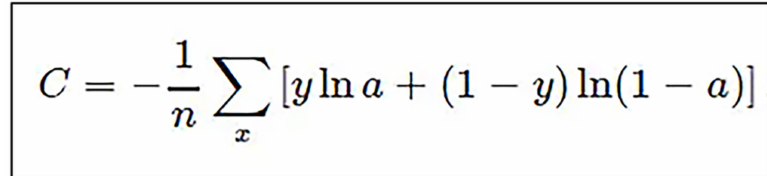
Figure 9. Example of im2latex-100k dataset images.